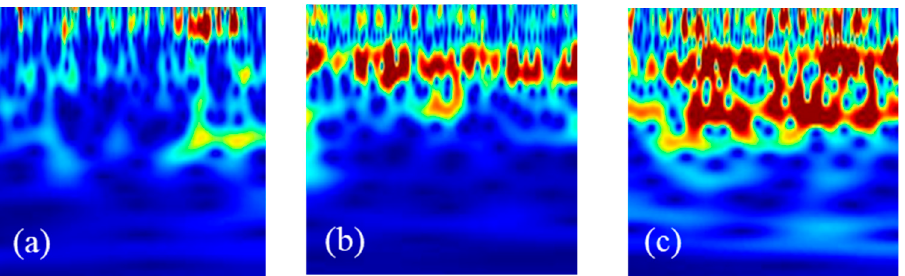
Figure 12. Typical scalogram image for ( a ) good surface quality, ( b ) marginal surface quality with minor cracks, and ( c ) poor surface quality.